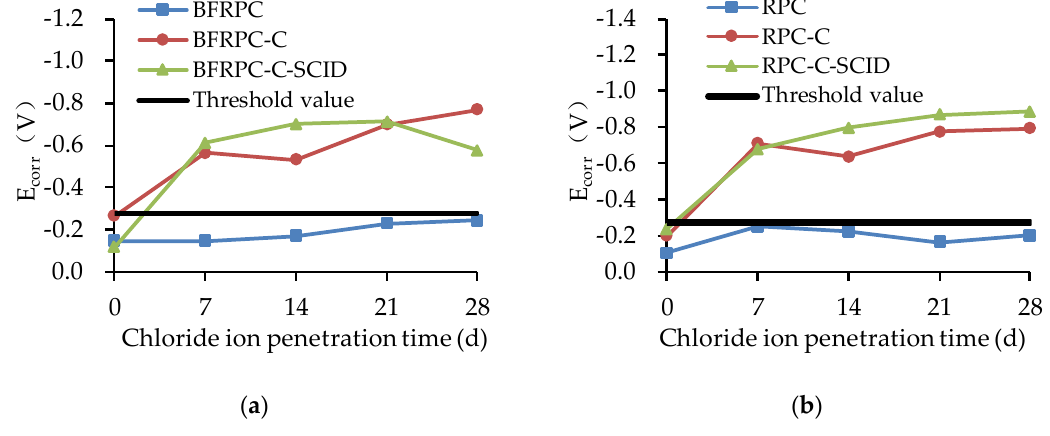
Figure 8. Corrosion potentials (E corr ) for: ( a ) BFRPC specimens; ( b ) RPC specimens.